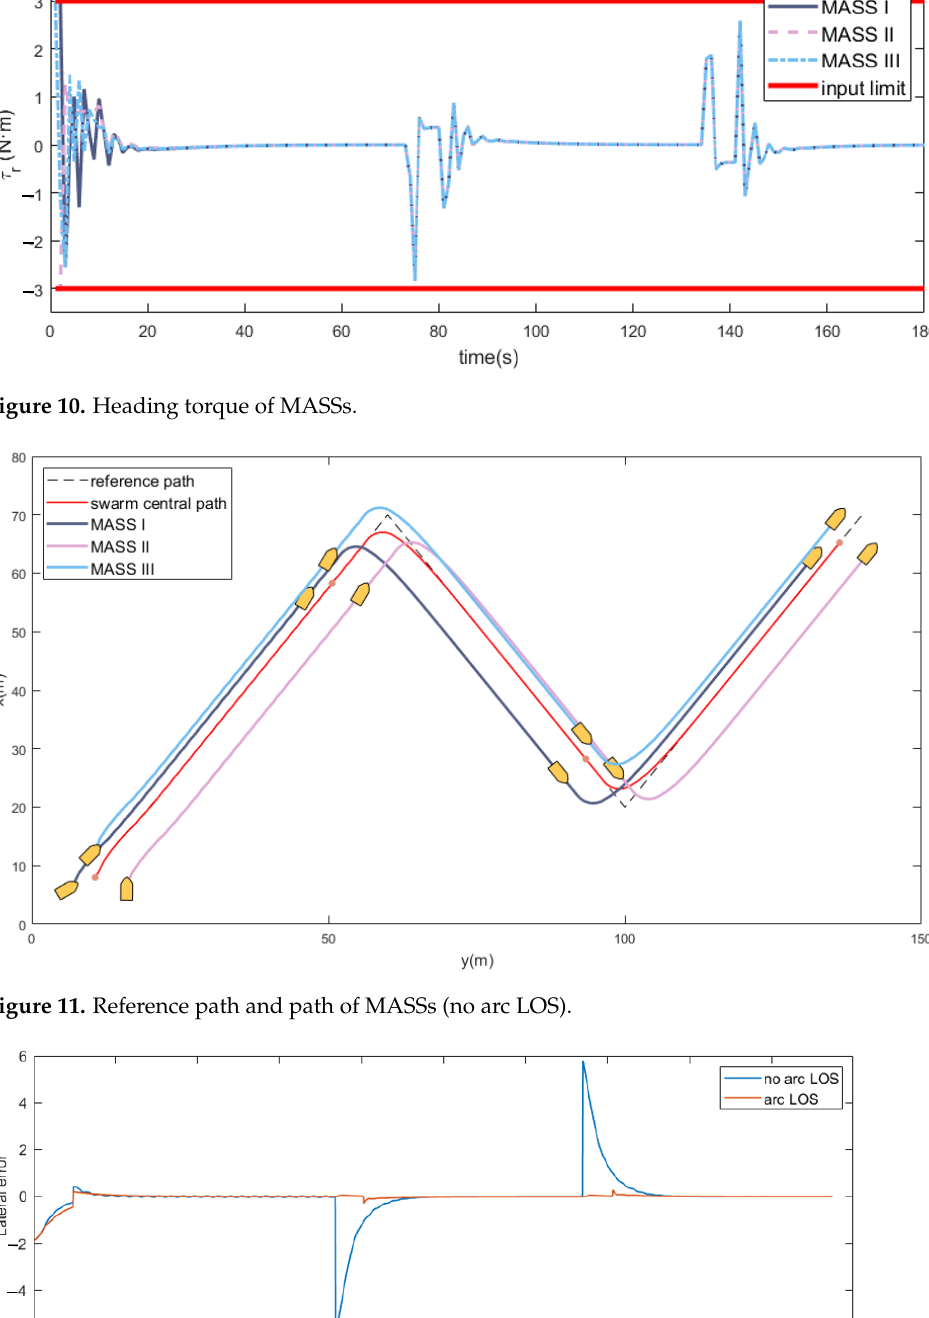
Figure 9. Heave thrust of MASSs.